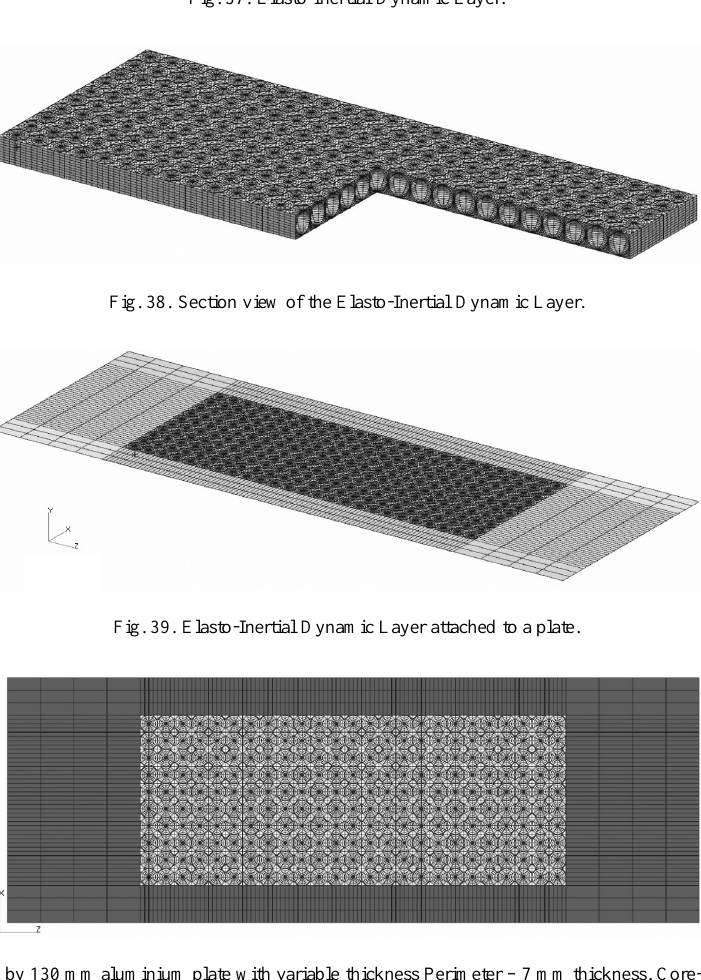
Fig. 37. Elasto-Inertial Dynamic Layer.